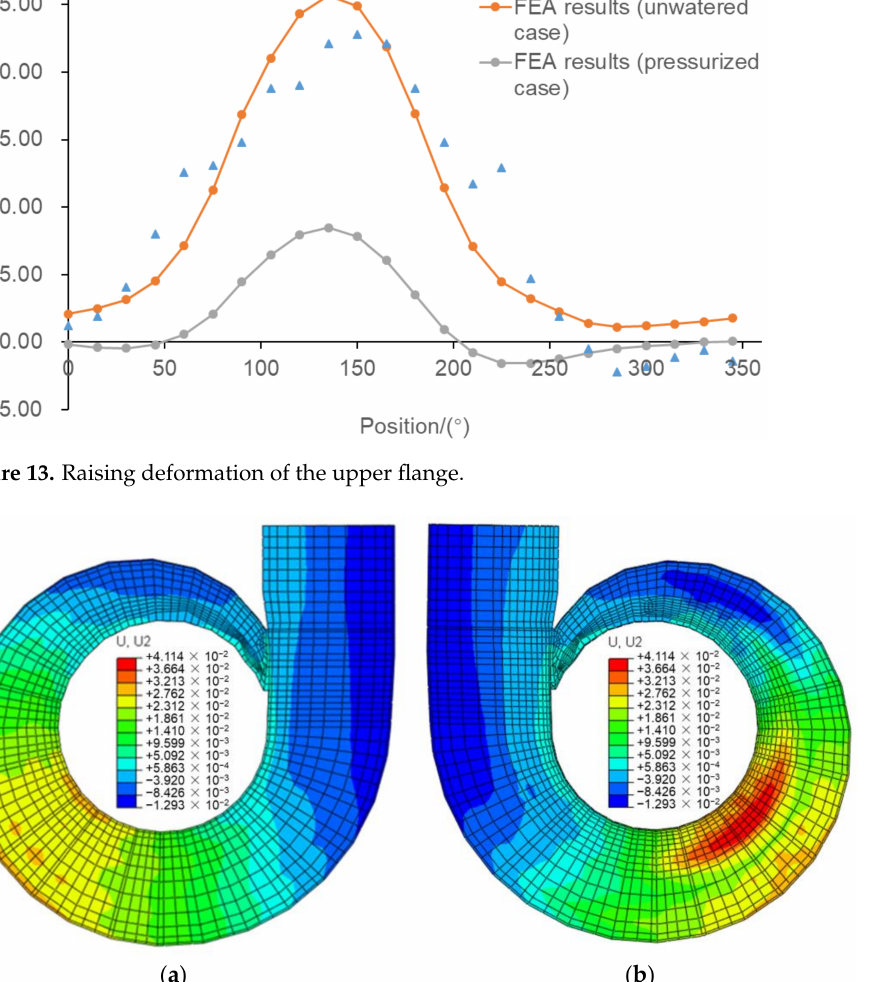
Figure 14. Vertical displacement of the SSC (unwatered case) (m): ( a ) top view; ( b ) bottom view.